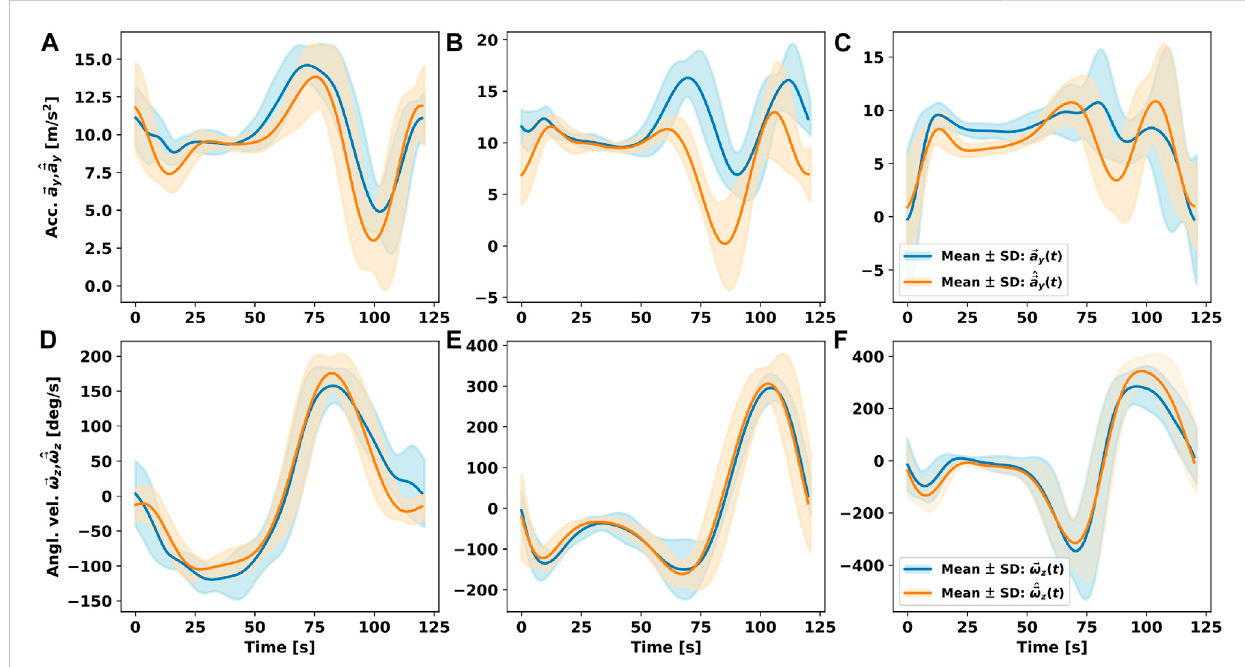
FIGURE 4 Comparison of accelerometer (Acc.) and gyroscope (Angl. vel.) measurements timeseries ( (cid:1) a y , (cid:1) ω z ) and synthesis timeseries ( acceleration. (B) Lowerlegacceleration. (C) Footinstepacceleration. (D) Upperlegangularvelocity. (E) Lowerlegangularvelocity. (F) Footinstepangular velocity.